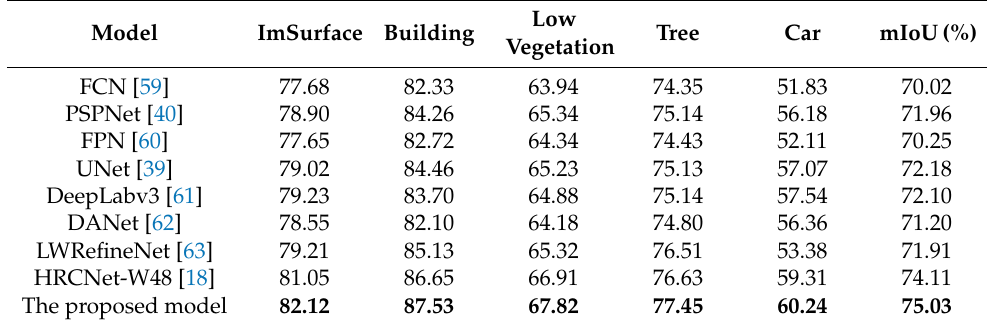
Table 7. The mean intersection over union (%) on the Vaihingen dataset with the above models. Model ImSurface Building